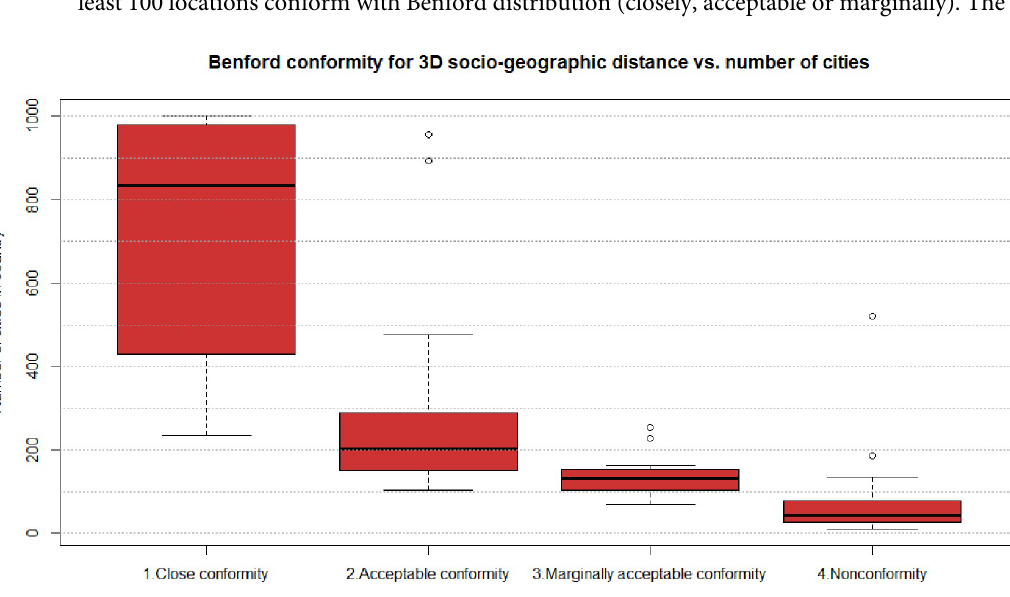
Fig 2. Relation between conformity to Benford distribution of 3D socio-geographic distance and number of cities in a country. Source: Own study with the use of benford.analysis:: R